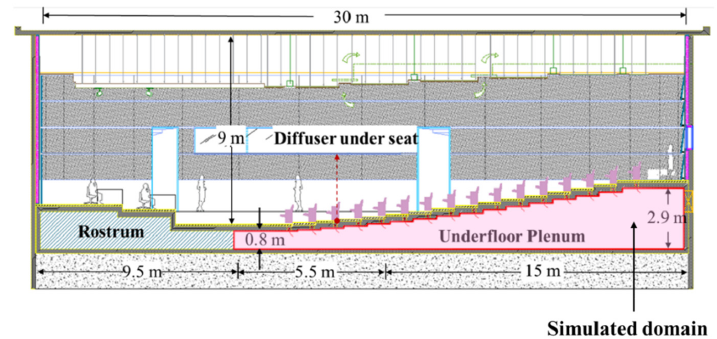
Figure 1. Vertical section of the circular conference room and simulated domain in this study.